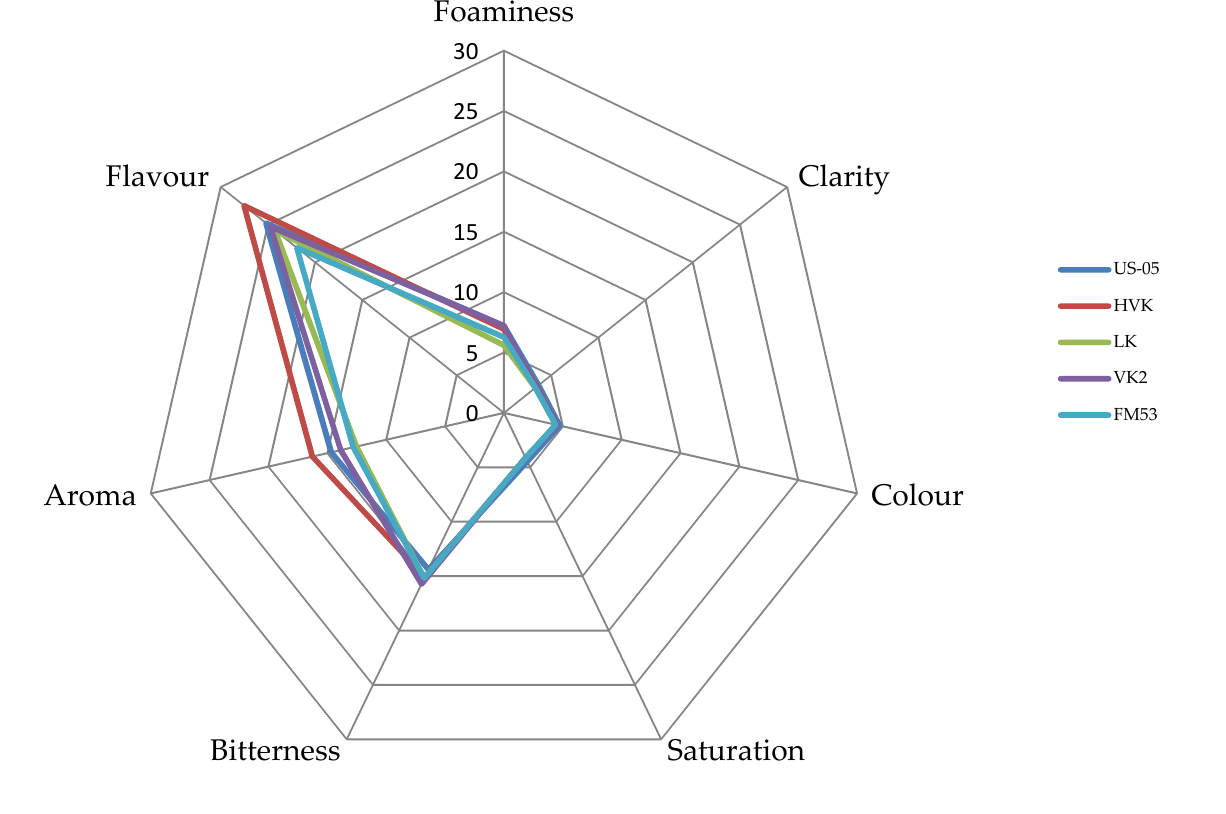
Figure 1. Results of the sensory analysis.